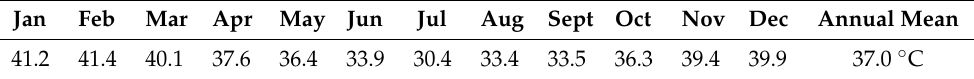
Table 3. Temperature ( ◦ C) rise for every month of the year (UK averages) [20]